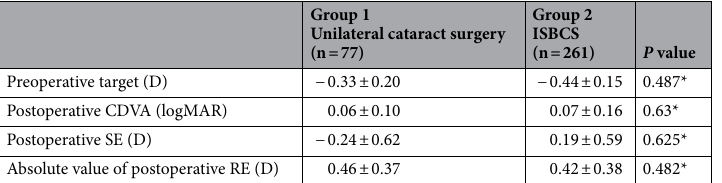
Table 2. Clinical outcomes one month after surgery. CDVA, corrected distance visual acuity; ISBCS, immediate sequential bilateral cataract surgery; RE, refractive error; SE, manifest spherical equivalent.